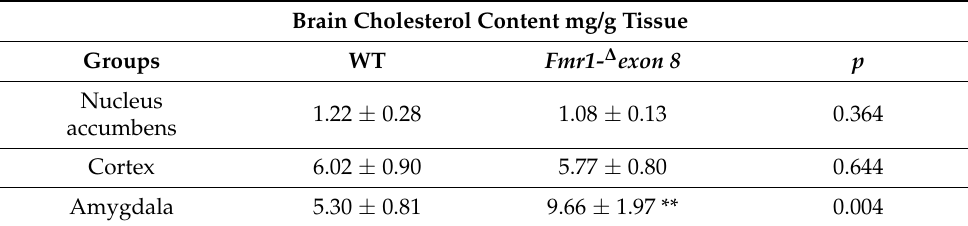
Table 3. Cholesterol content in nucleus accumbens, amygdala and prefrontal cortex (cortex) of Fmr1- ∆ exon 8 and WT adult (PND90) male rats.